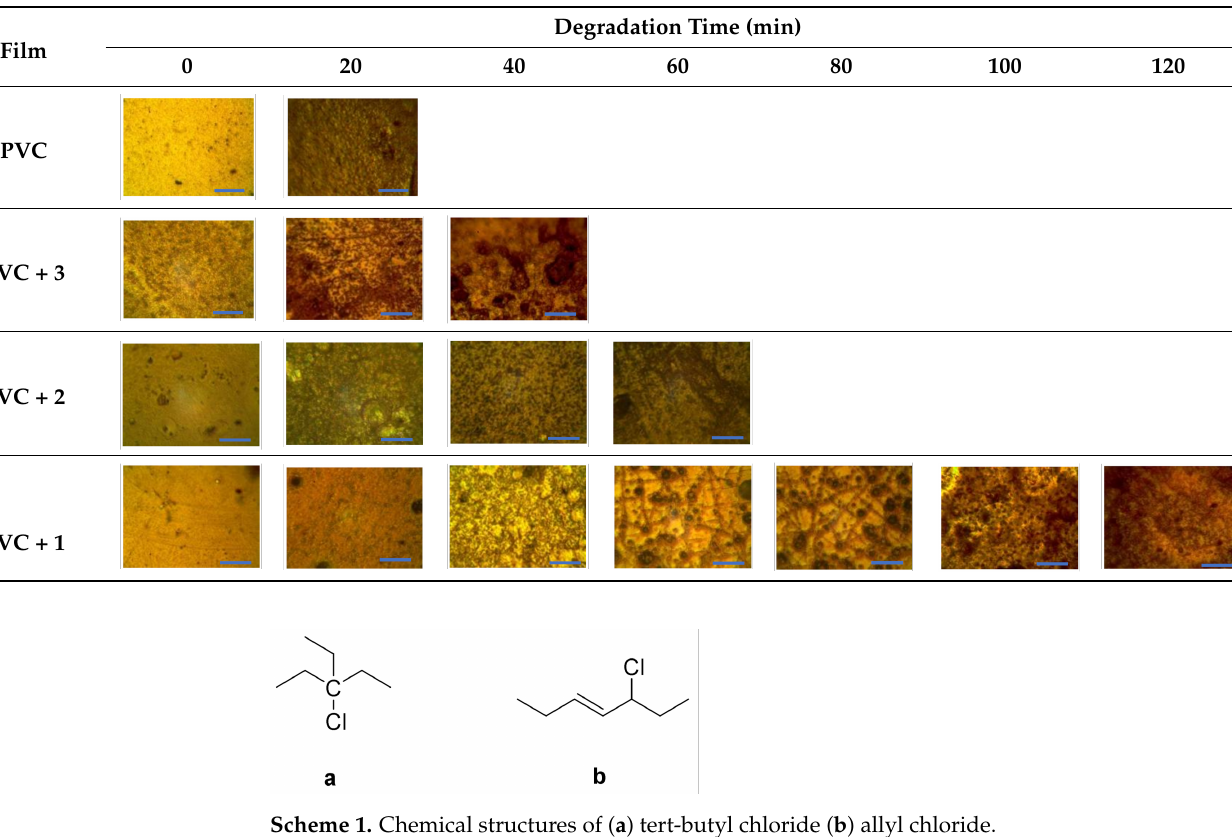
Table 1. Color evolutions of PVC films heated at 180 ◦